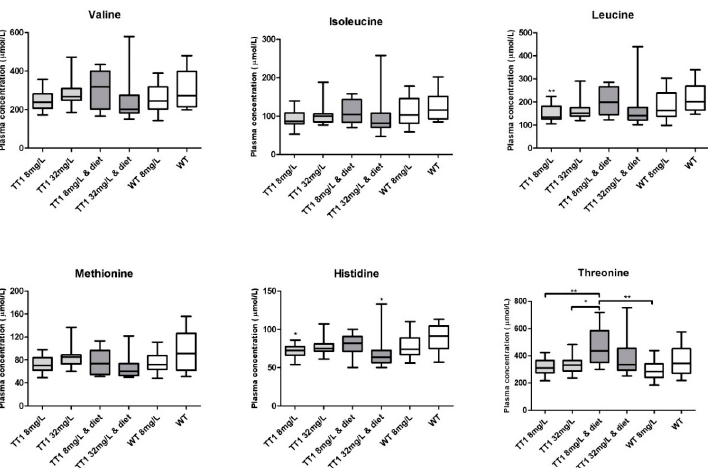
Figure 2. Plasma concentrations of the non-phenylalanine, tyrosine and tryptophan LNAA. Untransformed data are expressed as boxplots (min–max whiskers). Numbers of mice are n = 13 or n = 14 for all treatment groups. * p < 0.05, ** p < 0.01 (two-sided).